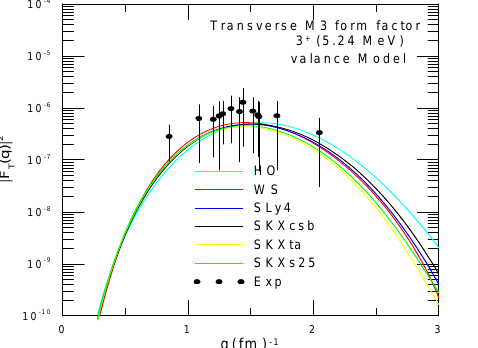
Fig.5: Theoretical transverse form factors for the first 3 + , 5.24 MeV state using different single particle potential compared with the experimental data taken from Ref. [36].